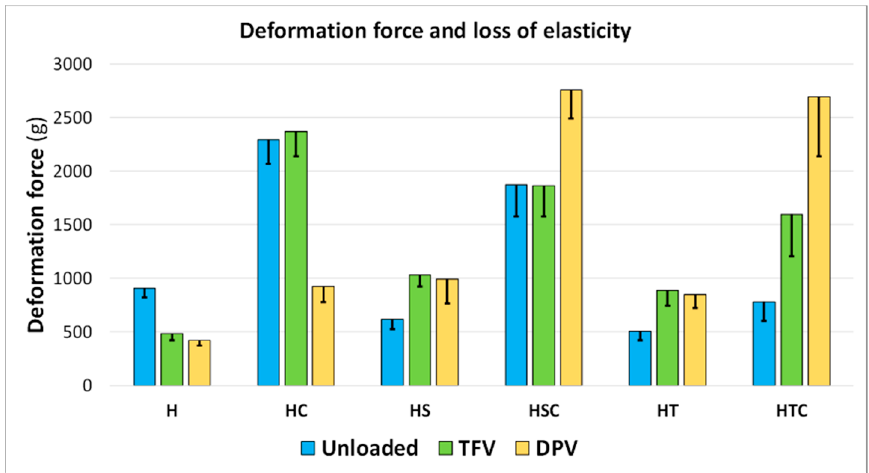
Figure 7. Mean values of the deformation force required to deform vaginal discs a distance of 1 mm ( n = 4). Inner bars represent the loss of elasticity after 10 deformation cycles.